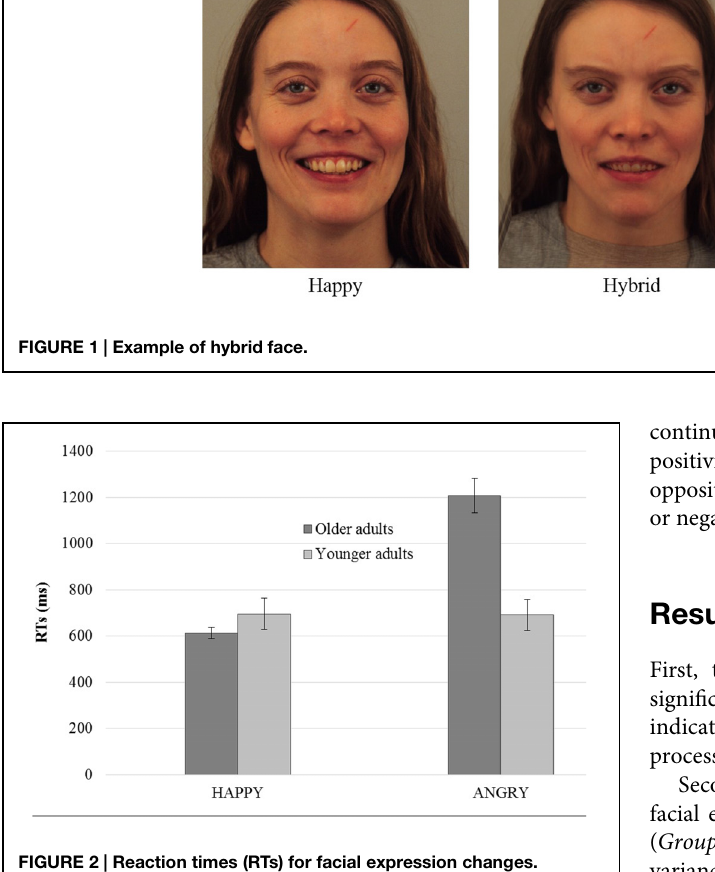
FIGURE 2 | Reaction times (RTs) for facial expression changes.